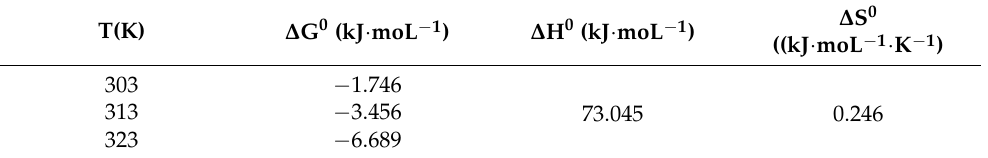
Table 9. Thermodynamic parameters for MB adsorption